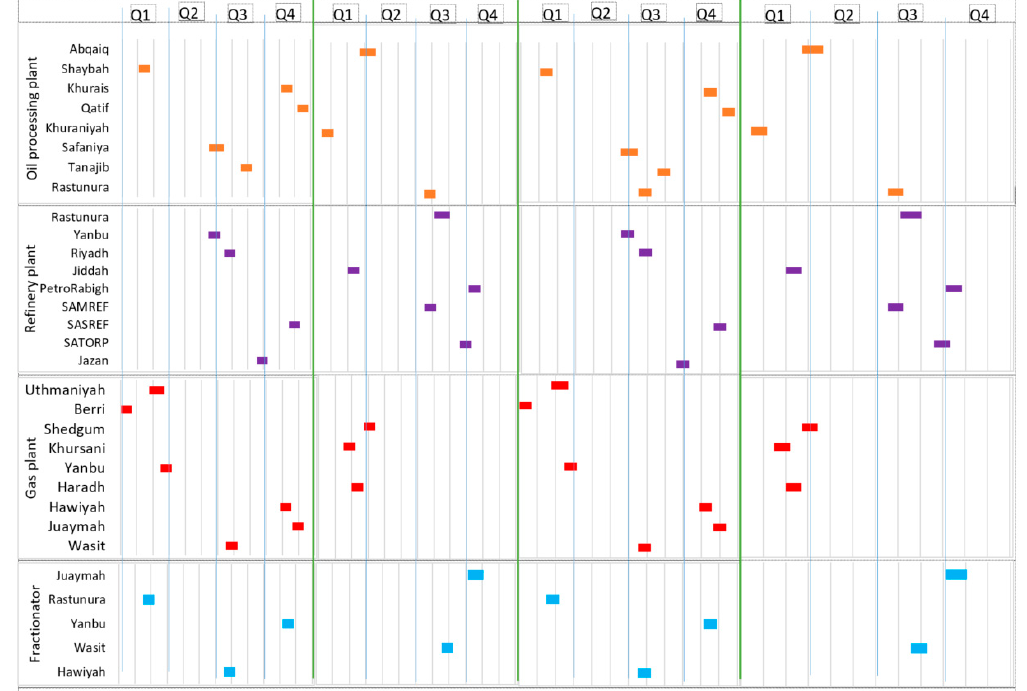
Figure 12. Maintenance schedule for all HCSC plants (maintenance model only); Color code: Orange: oil processing plants; Purple: Refinery plants; Red: Gas plants; Light Blue: Fractionator plants.